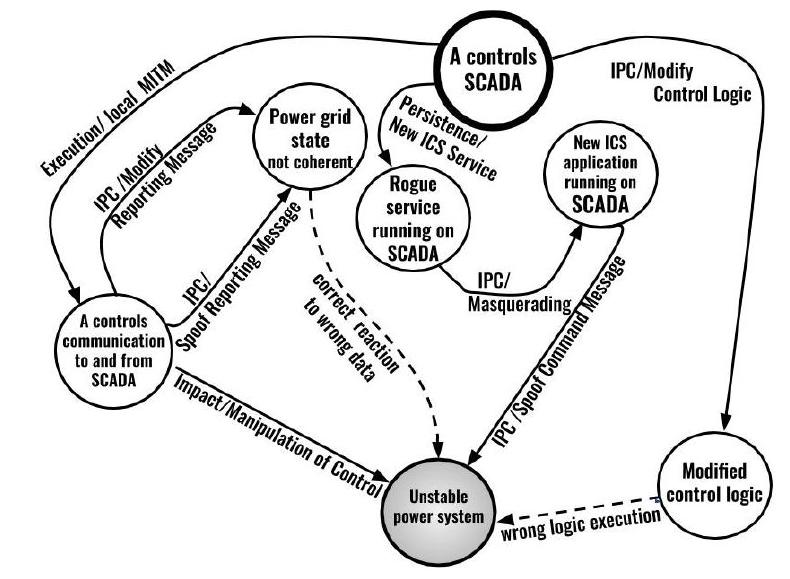
Figure 2. The attack